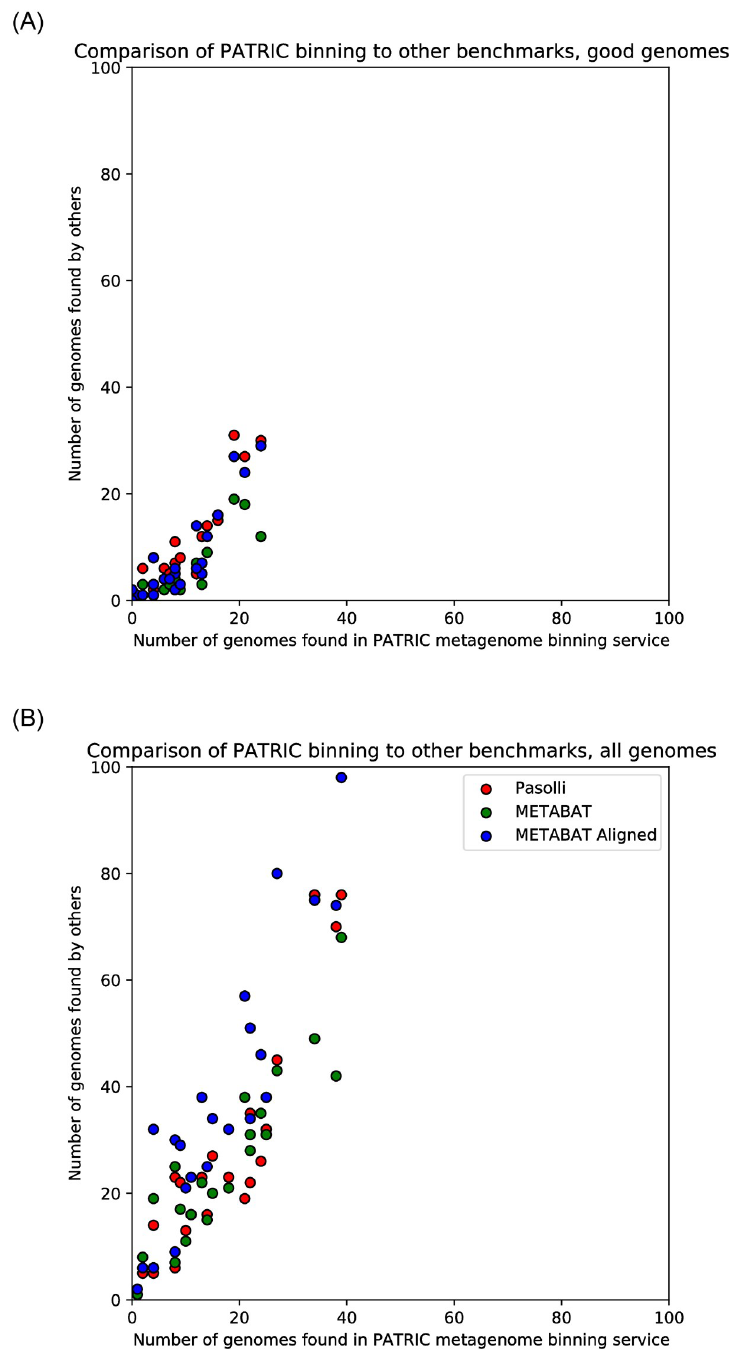
Fig 6. Comparison of PATRIC binning to other benchmarks. This plot indicates the number of total bins and high- quality bins (according to PATRIC criteria) generated by Pasolli et al. in their study, by our two benchmarks of MetaBAT2 (with and without alignments), and by the PATRIC metagenome binning service. Each point represents a sample; the left graph shows the number of high-quality bins found, while the right graph shows total bins found. Since Pasolli et al. is a good approximation of the state of the art in metagenome binning, this test suggests that the PATRIC binning method achieves performance close to the state of the art.